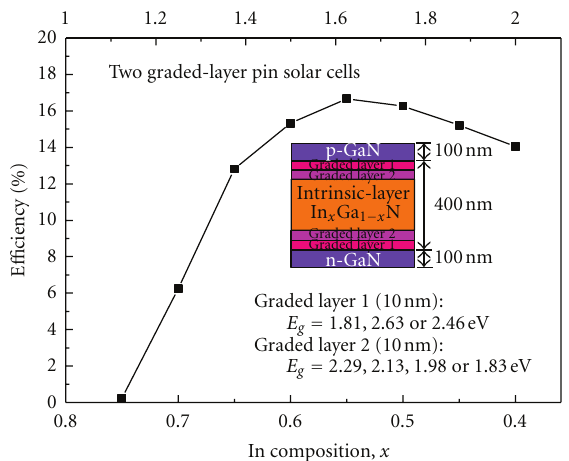
Figure 8: The e ffi ciency of two graded-layer pin solar cells as a function of In composition from 0.4 to 0.75. Clearly, the I - V curve begins to deform with increase of voltage bias when the In x Ga 1 − x N energy bandgap is lower than 2.42 eV ( x = 0 . 26). The deformation of I - V curve will gradually worsen with the decrease of In x Ga 1 − x N energy bandgap (increasing In composition). It means that the fill factor will become smaller. A completely deformed curve is observed in the In x Ga 1 − x N energy bandgap of 2.29 eV ( x = 0 . 3), which has a very low fill factor of 0.13. The